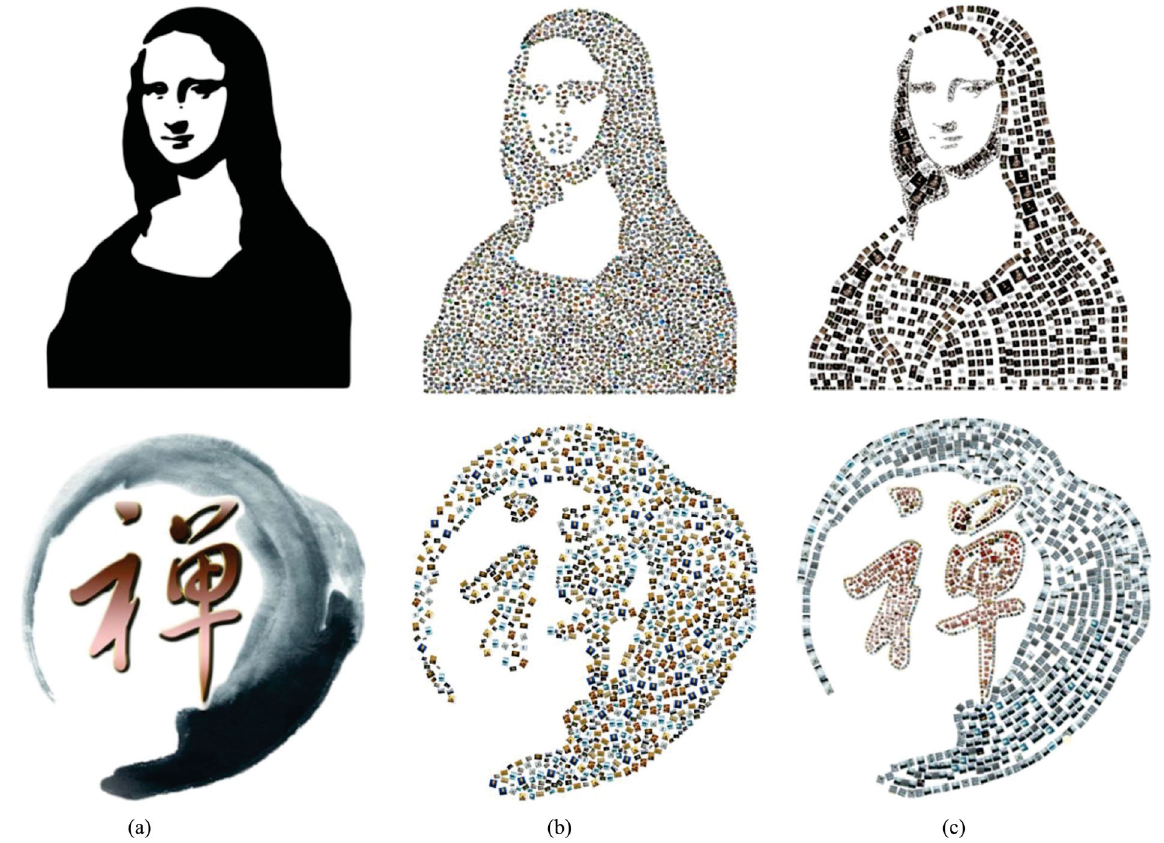
Fig. 10 Comparison with Shape Collage. Left to right: (a) source image, (b) results of Shape Collage, (c) results of our